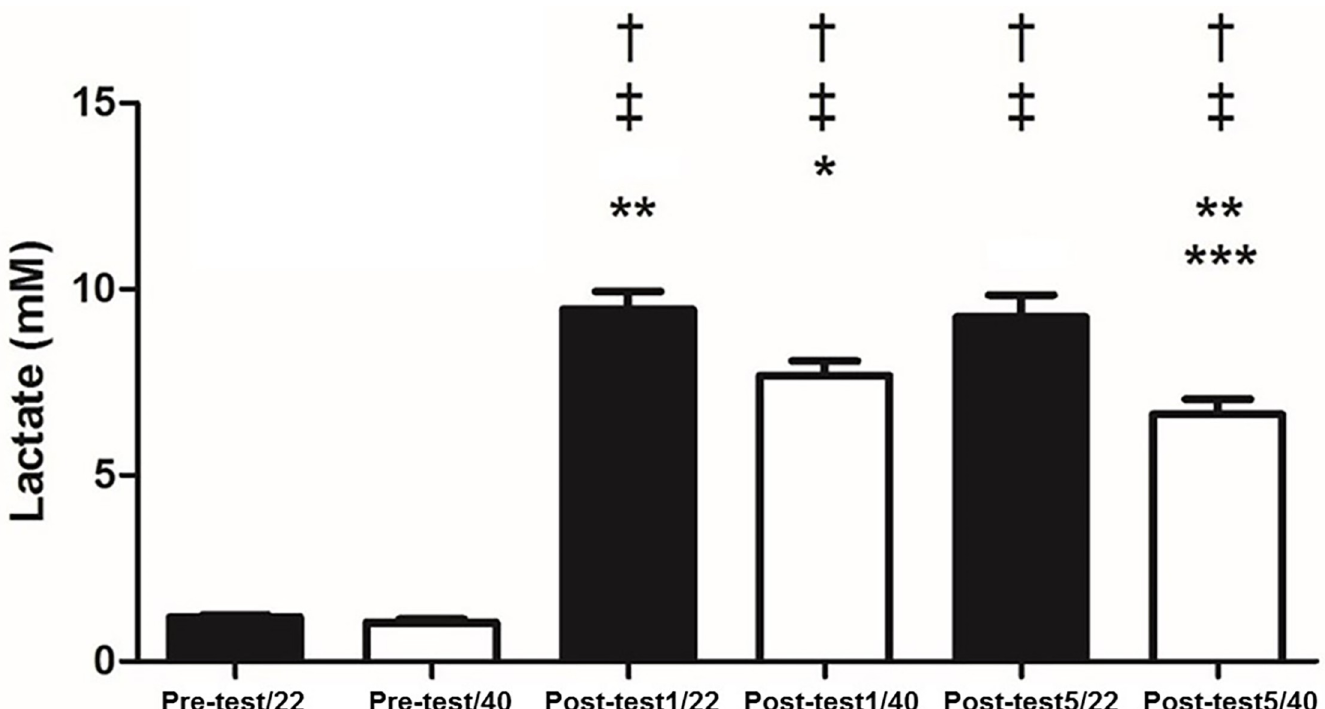
Fig 5. Blood lactate concentrations pre-test and at one (Post-test1) and five minutes (Post-test5) after exhaustion at 22 and 40˚ C. † p < 0.05 different from Pre- test/22; ‡ p < 0.05 different from Pre-test/40; � p < 0.05 different from Post-test1/22; �� p < 0.05 different from Post-test1/40; ��� p < 0.05 different from Post-test5/22.